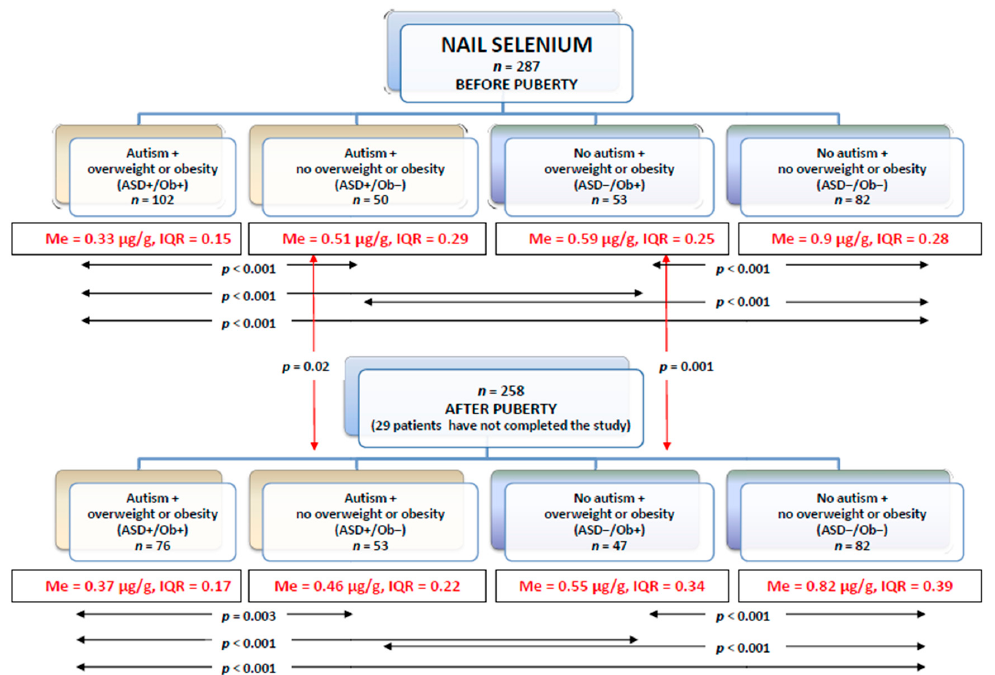
Figure 4. Toenail selenium levels in each group before and after puberty (Me—median, IQR—interquartile range).